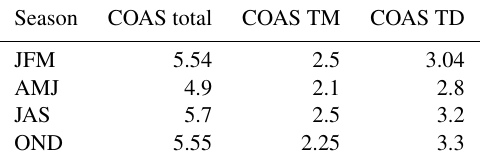
Table 1. Contributions to the wind work of the time-mean (TM) component (first term on the RHS of Eq. 4) and total time- dependent (TD) component (last three terms on the RHS of Eq. 4) from COAS, over the World´s oceans, in terms of sea- sons: January–February–March (JFM), April–May–June (AMJ), July–August–September (JAS), and October–November–December (OND). Units are terawatts,